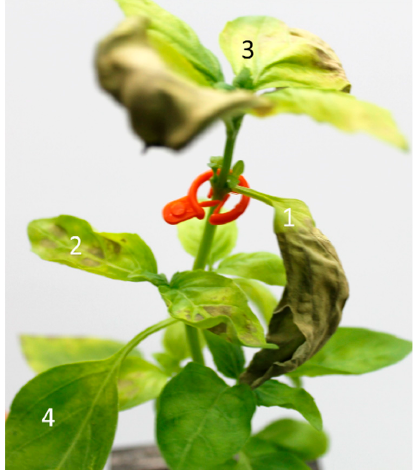
Figure 4. Symptoms of downy mildew in axillary buds of a basil plant. 1—Originally inoculated leaf (the other leaf was abscised). The red ring indicates the location of the originally inoculated leaves. 2—An infected axillary bud. 3—Infected apex. 4—Mild symptom on a leaf below the axillary bud.